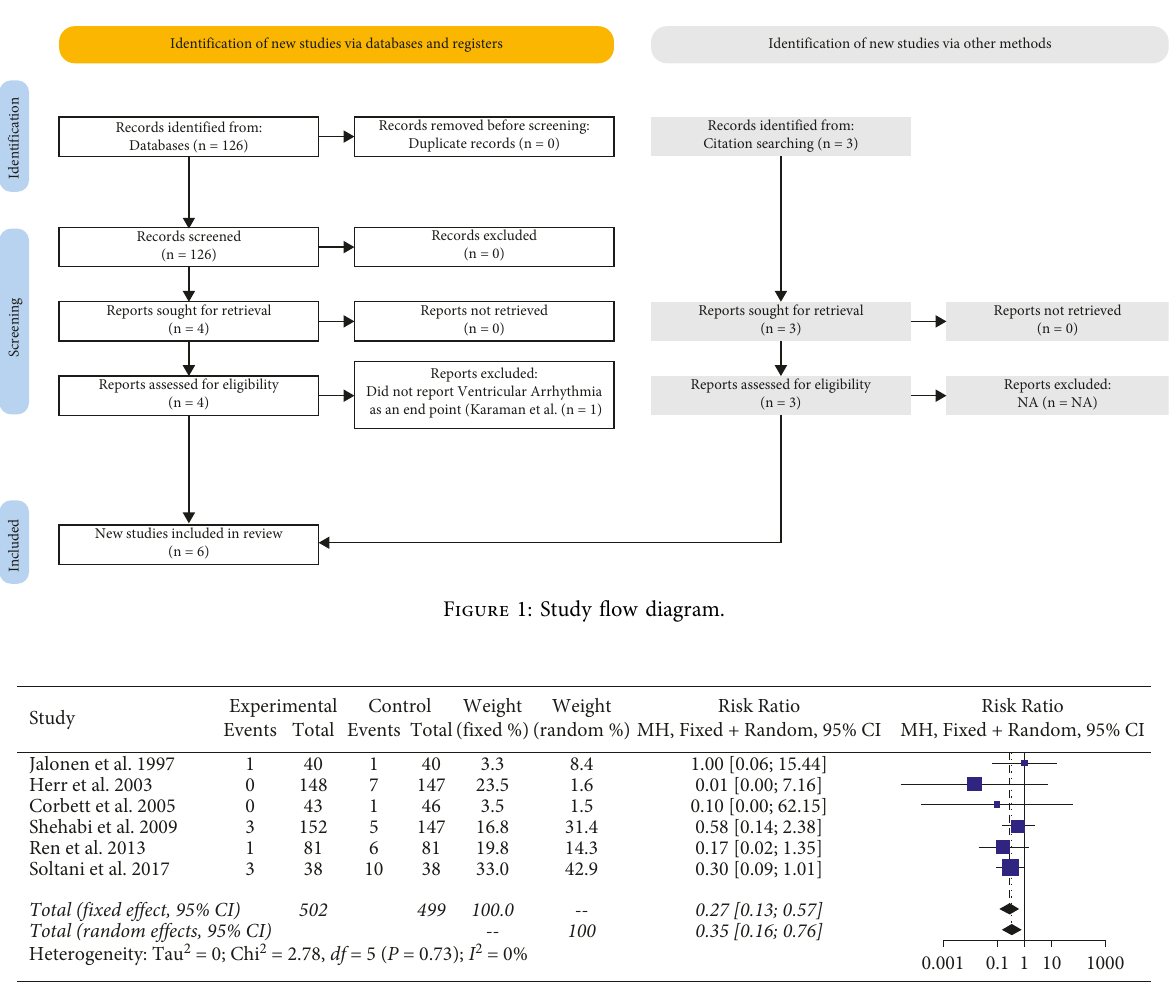
Figure 2: Meta-analysis of ventricular arrhythmias